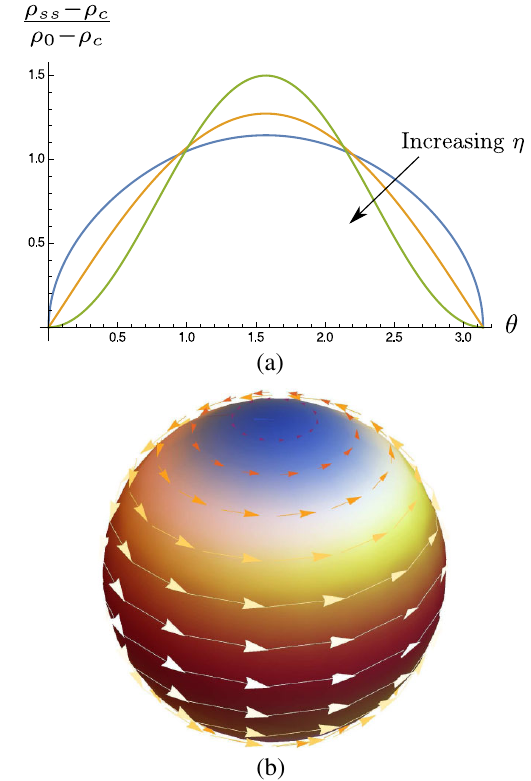
FIG. 1. (a) The normalized density profile of a polar flock on a sphere given in Eq. (12), for η ¼ 0 . 5 (blue), 1 (orange), and 2 (green). (b) The density and polarization profiles for η ¼ 2 , now shown on the sphere. The color describes the density from the maximum (red) at the center of the polar band to ρ poles of the sphere. The polarization also vanishes at the